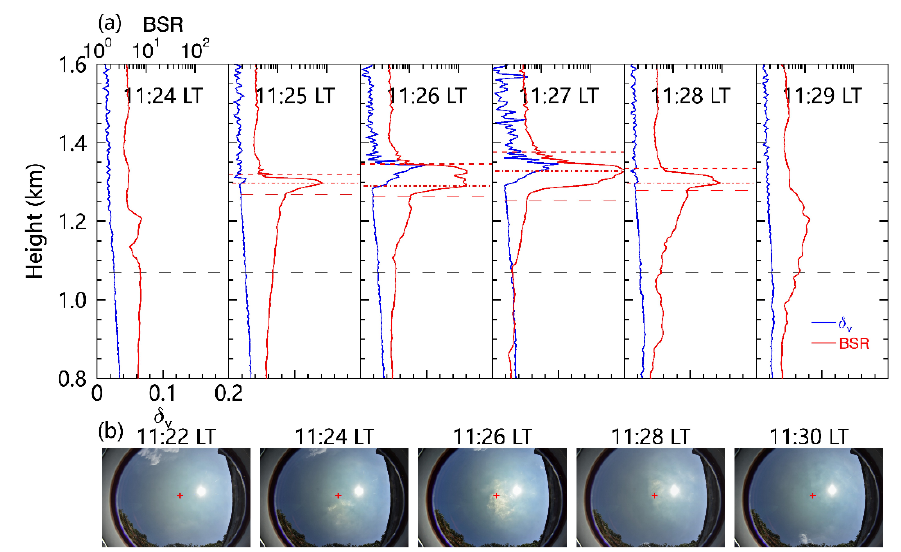
Figure 3. ( a ) Profiles of lidar backscatter ratio (R, red) and volume depolarization ratio ( δ V , blue) during 11:24–11:29 LT on the 9th of August, 2019, which display an example of individual shallow cumuli evolving from formation to disappearance. The lifting condensation level (LCL), cloud base height, cloud peak height, and cloud top height are shown, respectively, by black long dash, red long dash, red dash-dotted, and red short dash lines. ( b ) Photographs of the sky recorded by a ground-based camera at our lidar site, which display the evolving appearance of this shallow cumulus. The center of the plus symbol shows the region which is in the field-of-view of the lidar.